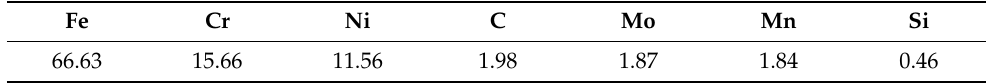
Table 1. Matrix element composition of 316L stainless steel (wt.%).